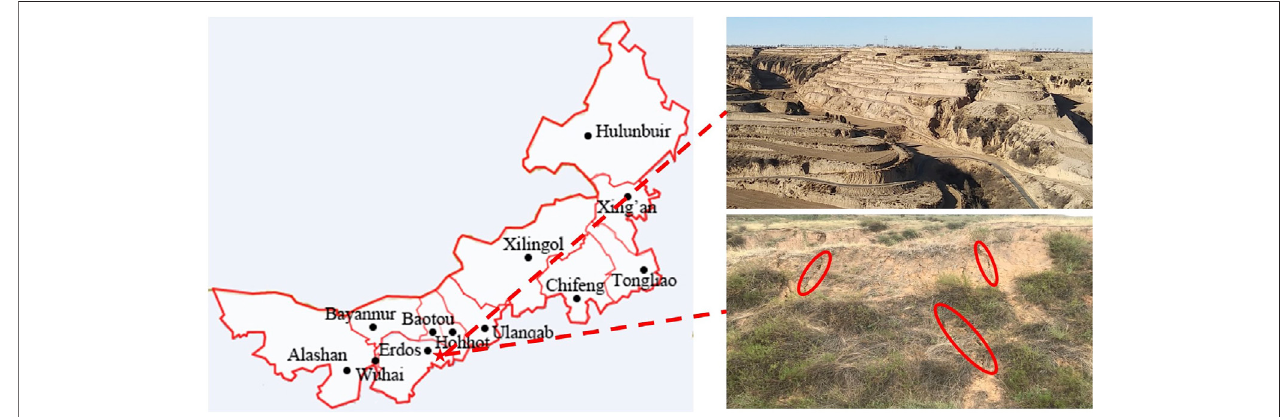
FIGURE 1 | Topography and geographical location of the mining area.